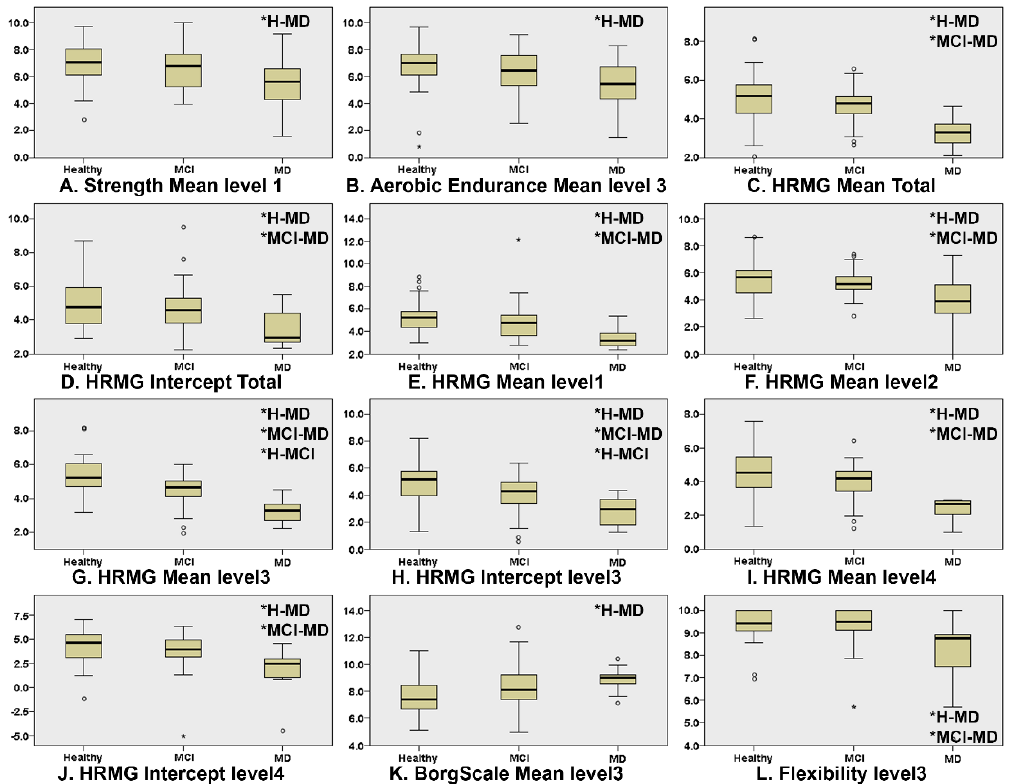
Figure 1. Boxplots of the features where there was statistically significant differences in at least one of the group couple comparisons, namely, CN–MCI, CN–MD and MCI–MD. Independent samples of Kruskal–Wallis were used throughout. HRMG stands for the High-Resolution Monitoring Games, Borg scale is the rating of perceived exertion, strength, aerobic and flexibility represent the scores of the corresponding physical exercises. (* indicates which groups significantly differ from each other).